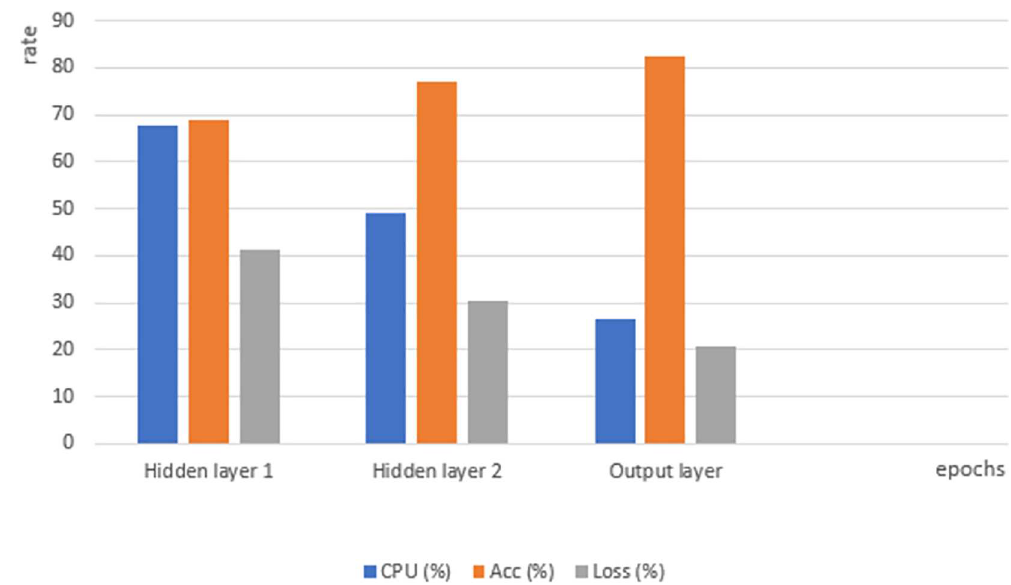
Fig 27. Average CPU time and model’s efficiency through each layer.